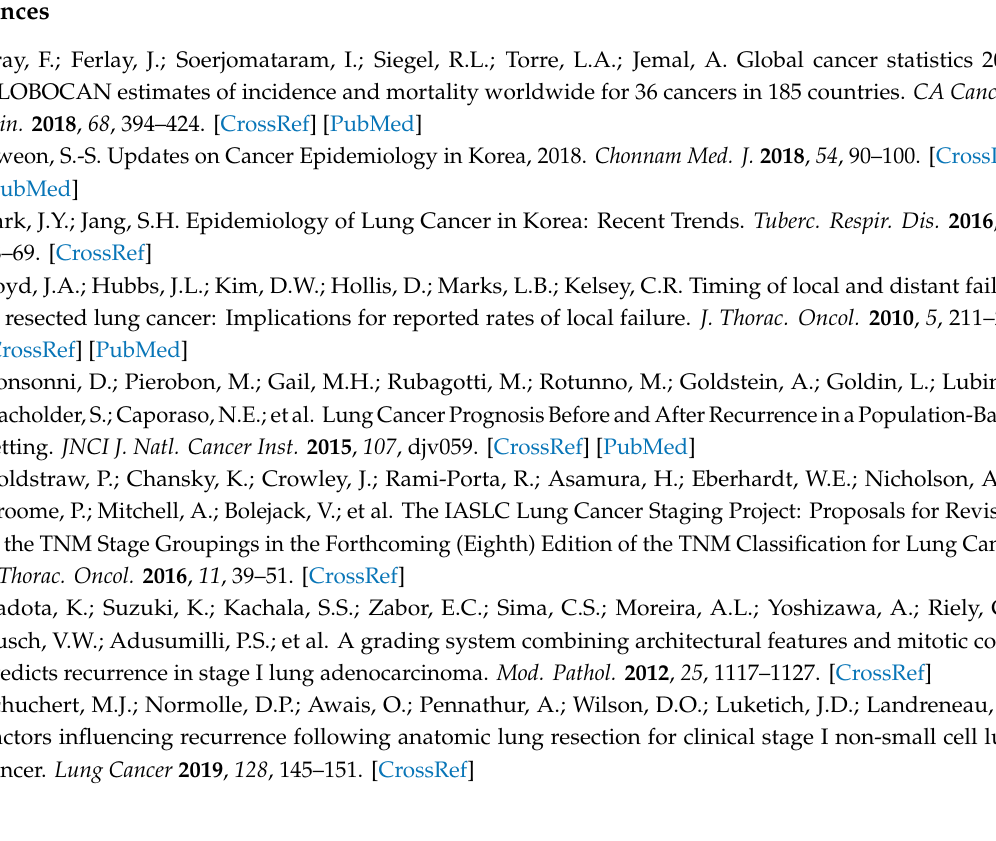
Table S1: Sensitivity and specificity in the prediction of postoperative recurrence on the basis of di ff erent cuto ff GPx3 change